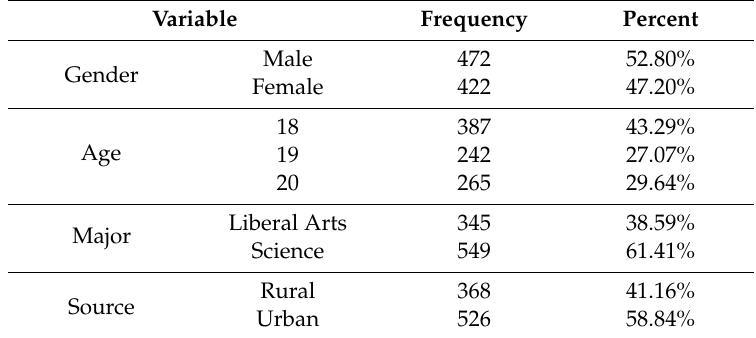
Table 1. Demographics of respondents ( n =